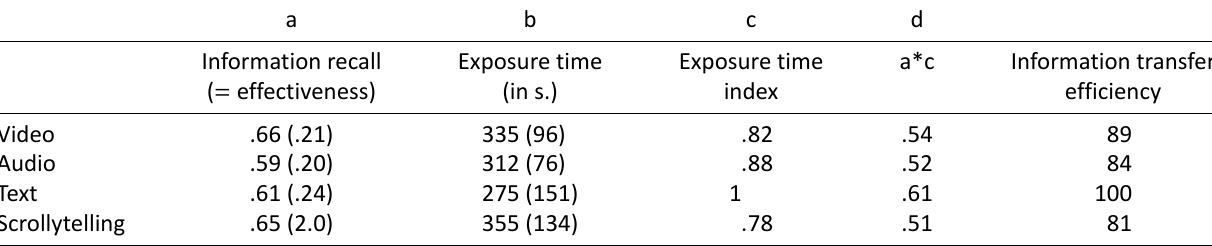
Table 4. Information transfer effectiveness and